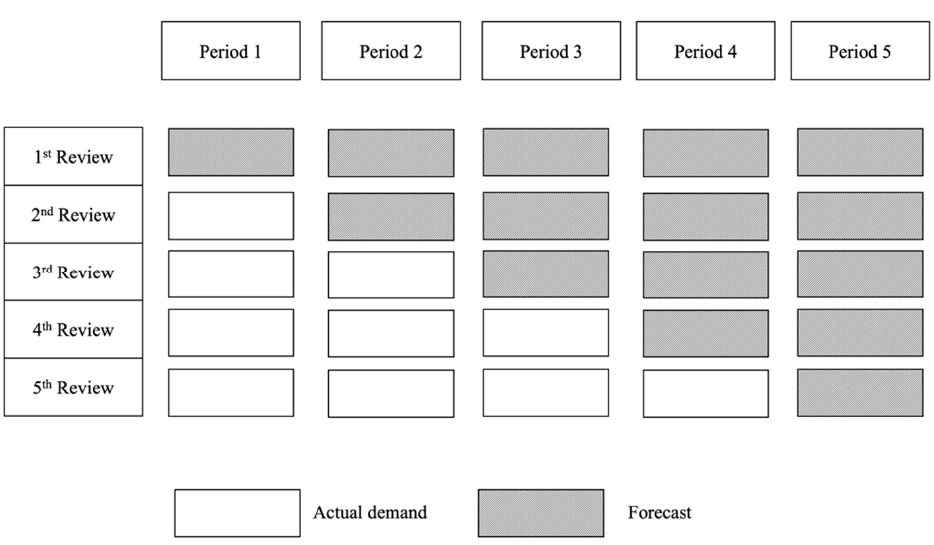
Figure 5. Rolling forecast schematic.